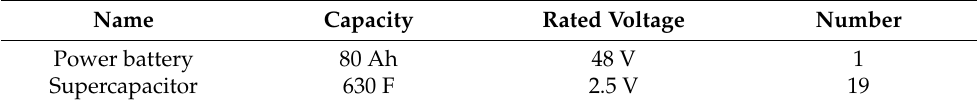
Table 2. Parameters of the hybrid power system.